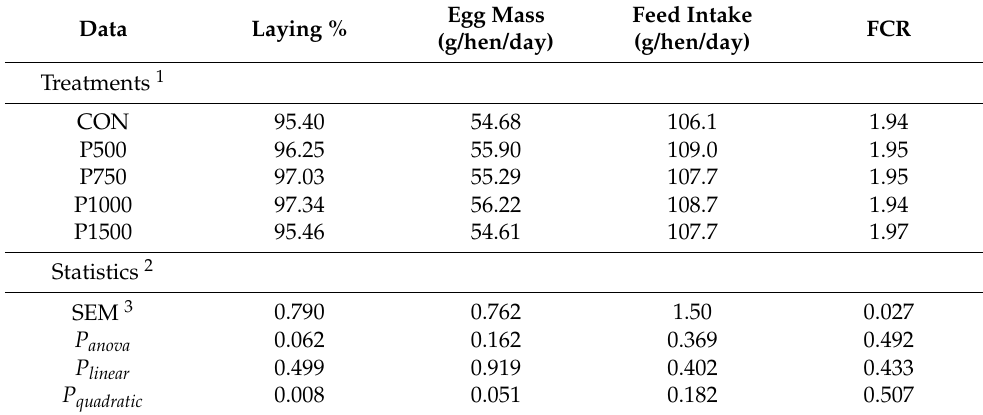
Table 2. Overall performance parameters of laying hens during weeks 1 to 8 of the experiment.